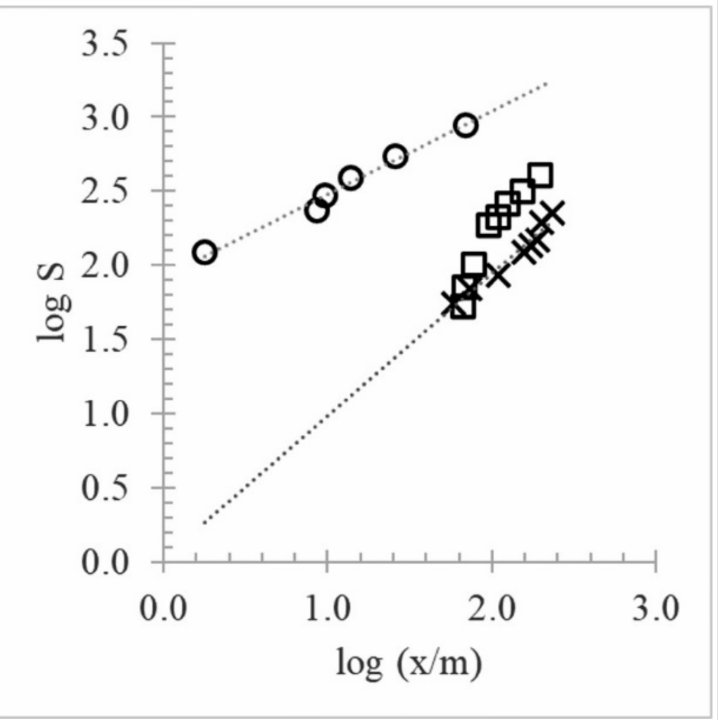
Figure 5. Freundlich plot of grape seed tannin adsorption by fining agents. Legend: PVPP (X); PP ( (cid:3) ); BSA ( (cid:35)